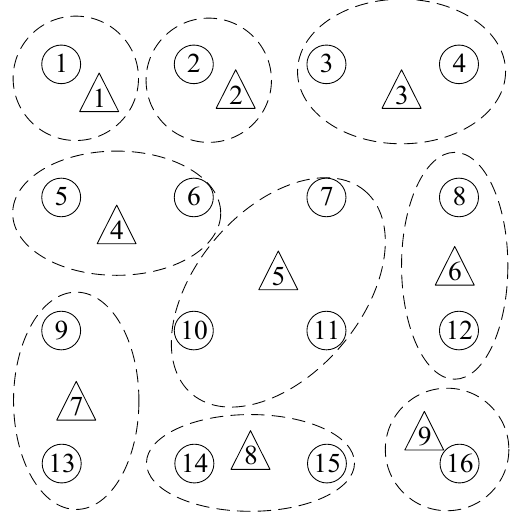
Figure 8. The corresponding graph of natural gas load node and electric load node.